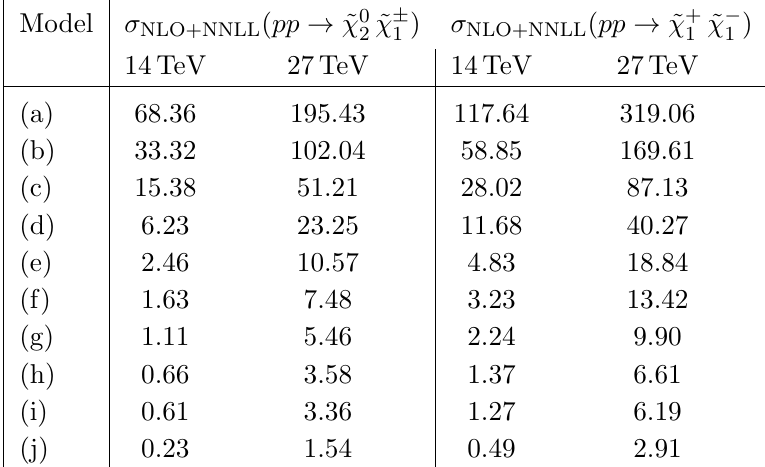
signal and background events are simulated at LO with up to two partons at generator level using MadGraph5 aMC@NLO-2.6.3 interfaced to LHAPDF [87] using the